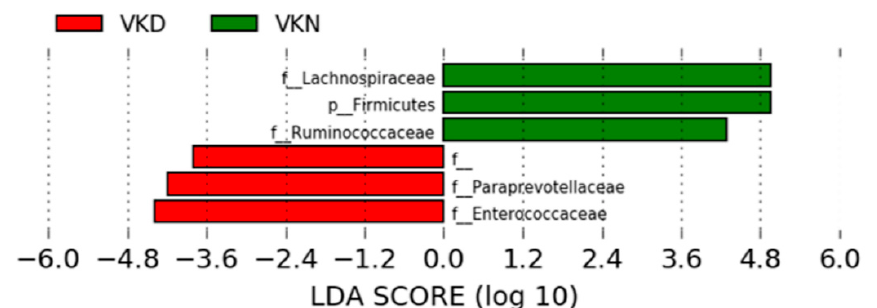
Figure 5. Gut microbiota at the family level in the vitamin K-satisfactory state. The enriched gut microbiota at the family level were identified by linear discriminant analysis (LDA)effect size (LEfSe). The operational taxonomic units (OTUs) with an LDA score of >2 are shown. VKN, vitamin K-normal group; VKD, vitamin K-deficient group; LDA, linear discriminant analysis; f__, order__ Clostridiales ;family__; p, phylum; f, family.